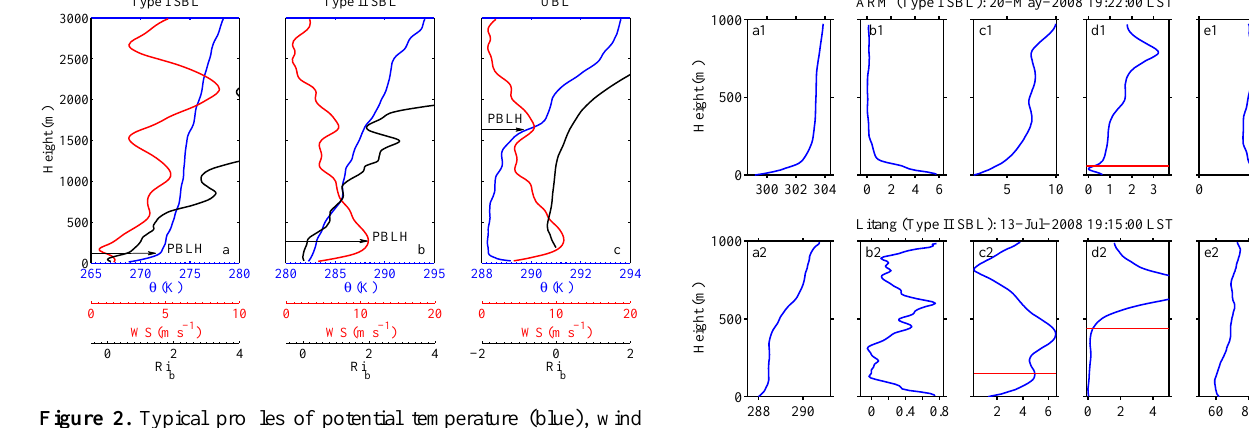
Figure 2. Typical profiles of potential temperature (blue), wind speed (red), and Ri b (black) for different types of boundary lay- ers: (a) type I SBL, (b) type II SBL, and (c) UBL. The indicated PBLHs in (a–c) are calculated by the PTG, LLJ, and modified par- cel methods, respectively. The observations in (a–c) are from Litang on 8 July 2008 16:35UTC (00:35LST), 8 July 2008 22:45UTC (06:45LST), and 9 July 2008 04:45UTC (12:45LST), respectively.